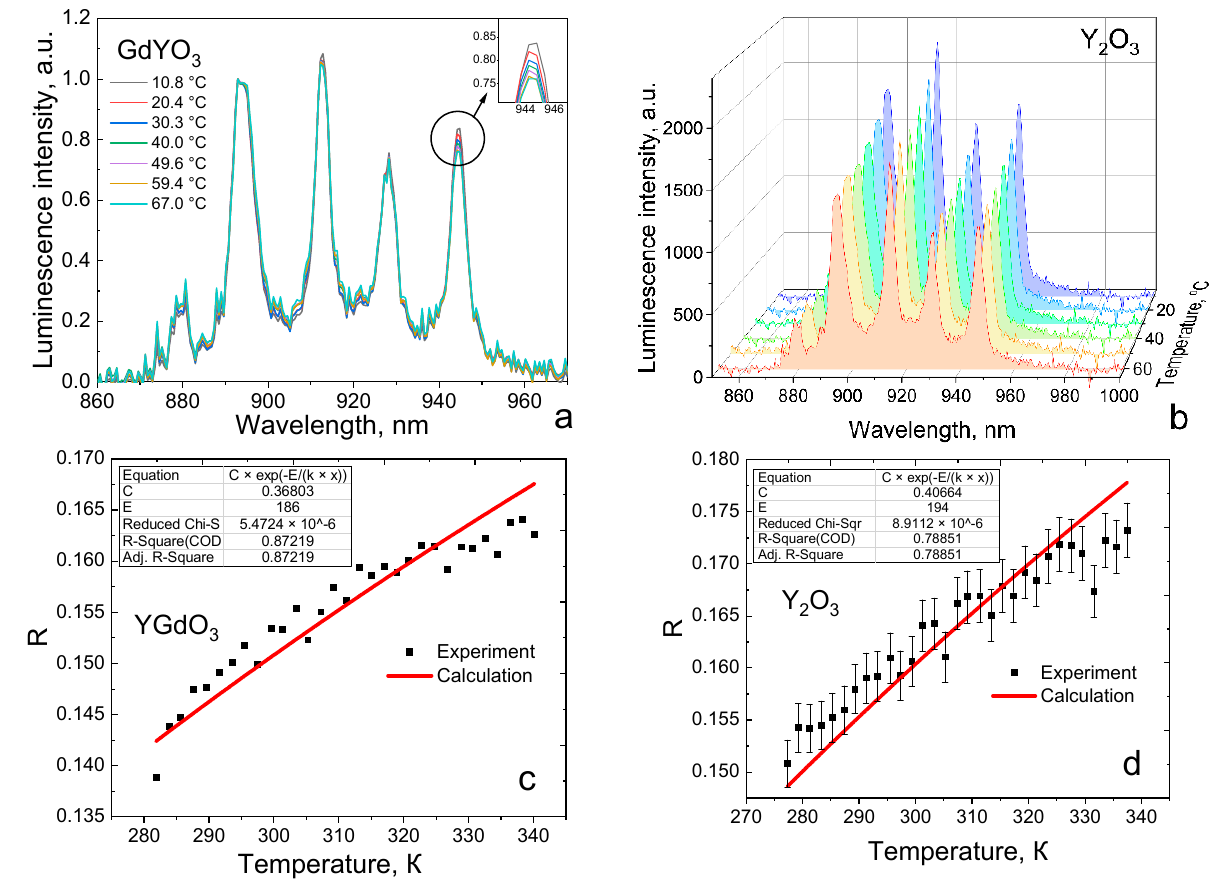
Figure 6. Fluorescence spectra’ temperature dependence of Nd-doped GdYO 3 ( a ) and Y 2 O 3 ( b ); Luminescence intensity ratio R as a function of temperature for GdYO 3 ( c ) and Y 2 O 3 ( d ) powders. Red lines correspond to the fitting by an exponential function.